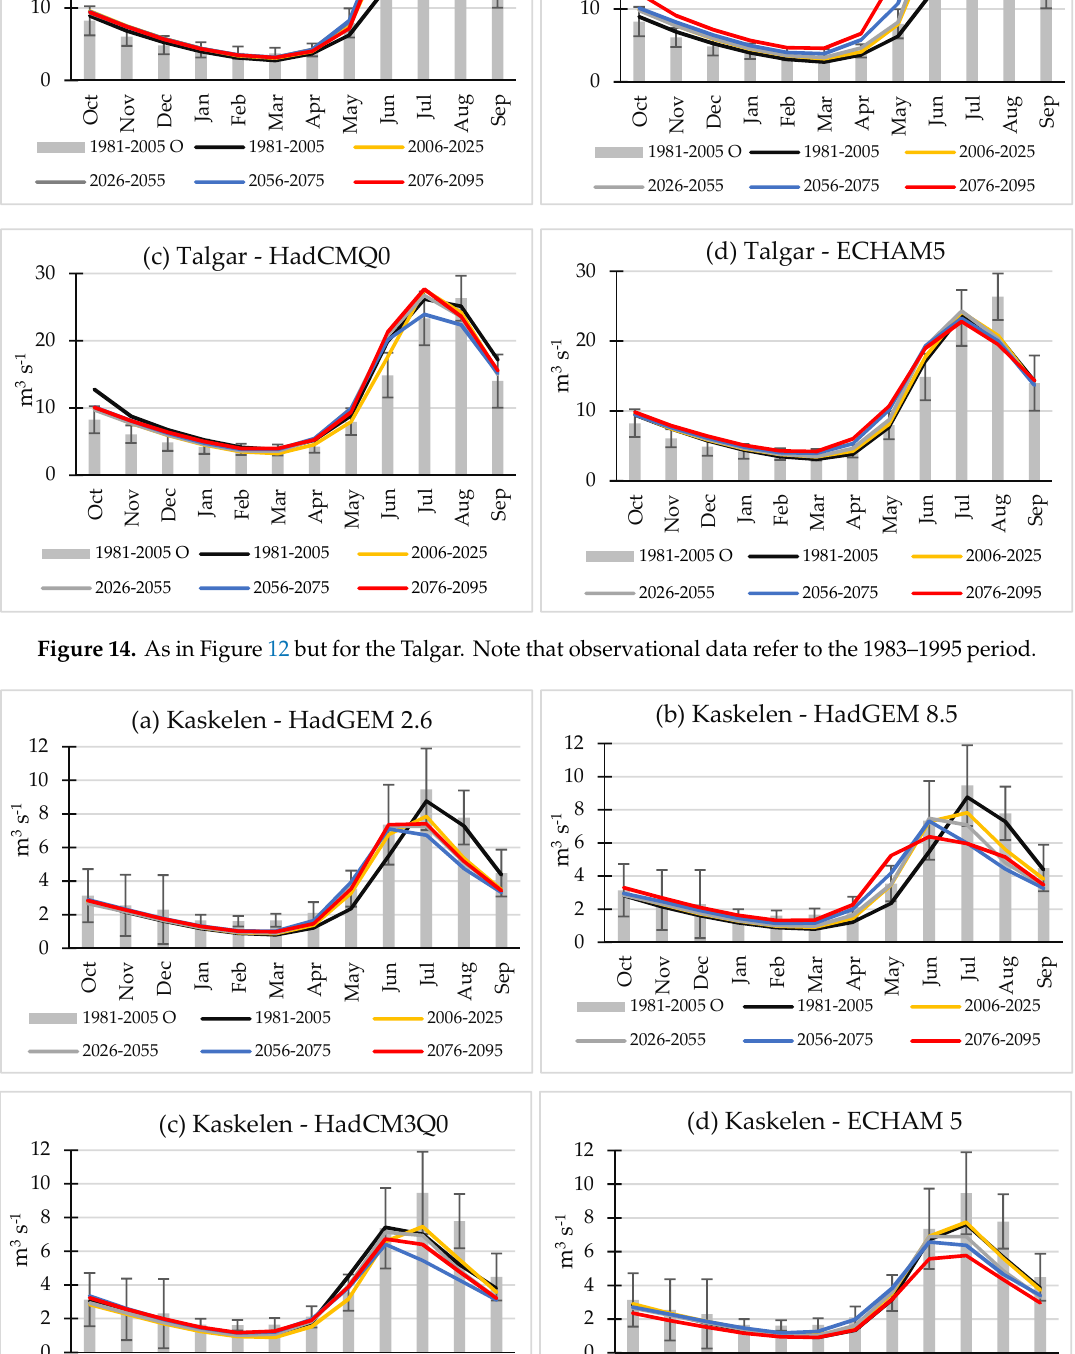
Figure 15. As in Figure 12 but for the Kaskelen.